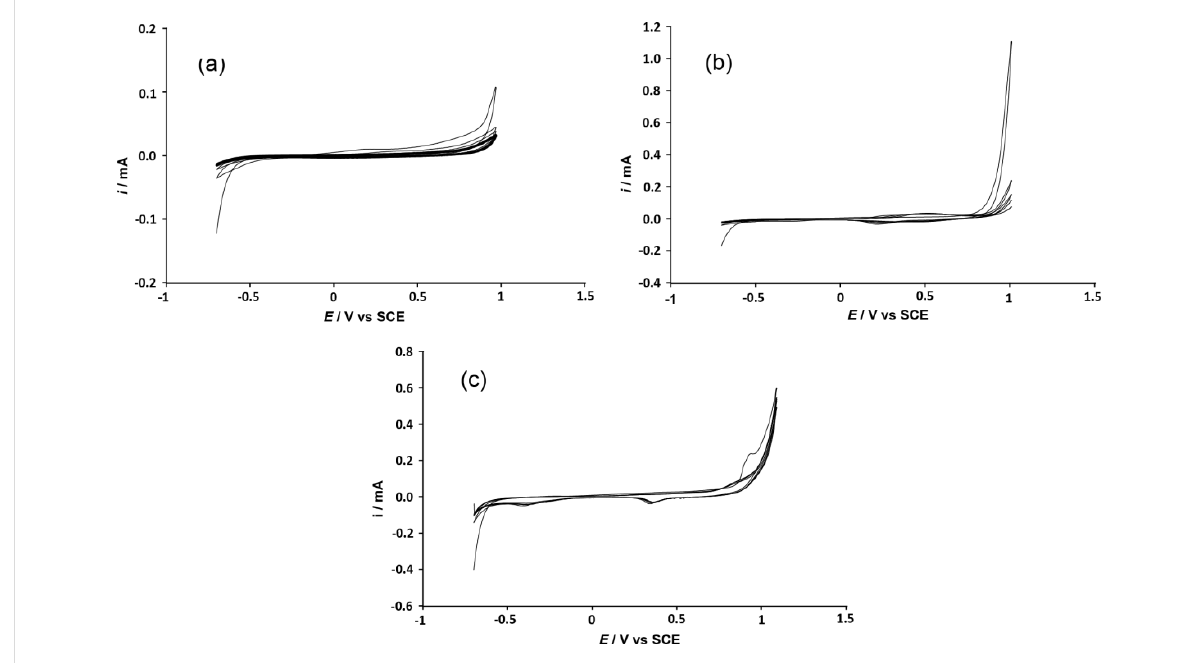
Figure 2: Cyclic voltammogram of polyindoles. (a) Indole-6-F 8 , (b) Indole-6-F 6 and (c) Indole-6-F 4 (5 scans at 20 mV·s − 1 ). Electropolymerization in 0.1 M of acetonitrile/Bu 4 NClO 4